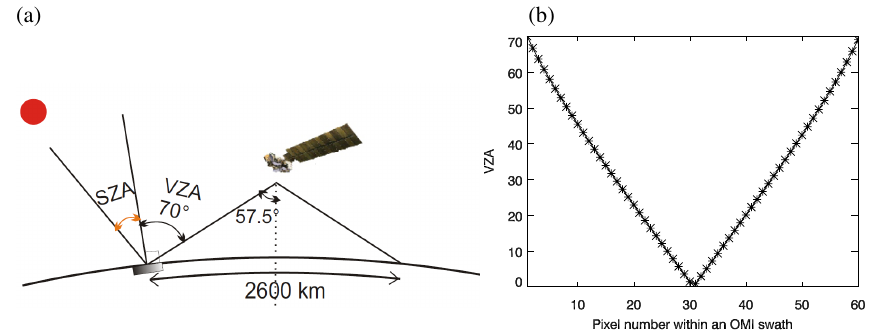
Fig. 1: (a) Viewing geometry for the OMI swath. Due to Earth curvature, the surface viewing zenith angle (VZA) is larger than its value at the satellite. (b) VZA variation for the 60 pixels within an OMI swath.